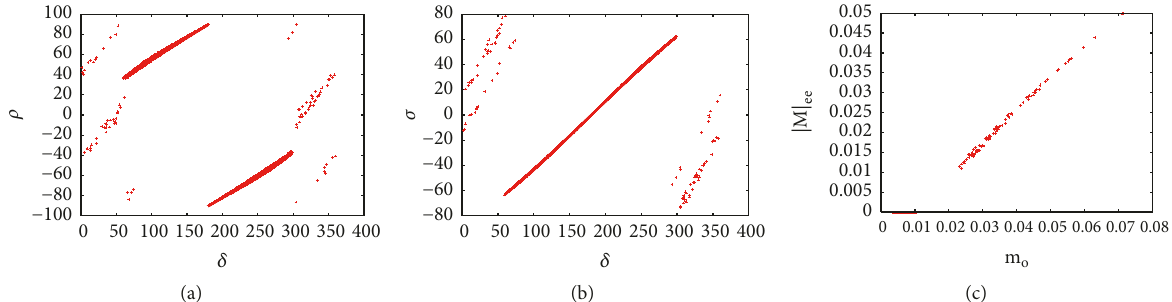
Figure 11: Correlation plots for texture 𝐸 1 (NS) for type X at 3 𝜎 CL. The symbols have their usual meaning. 𝛿, 𝜌 , and 𝜎 are measured in degrees, while |𝑀| 𝑒𝑒 and 𝑚 0 are in eV units..